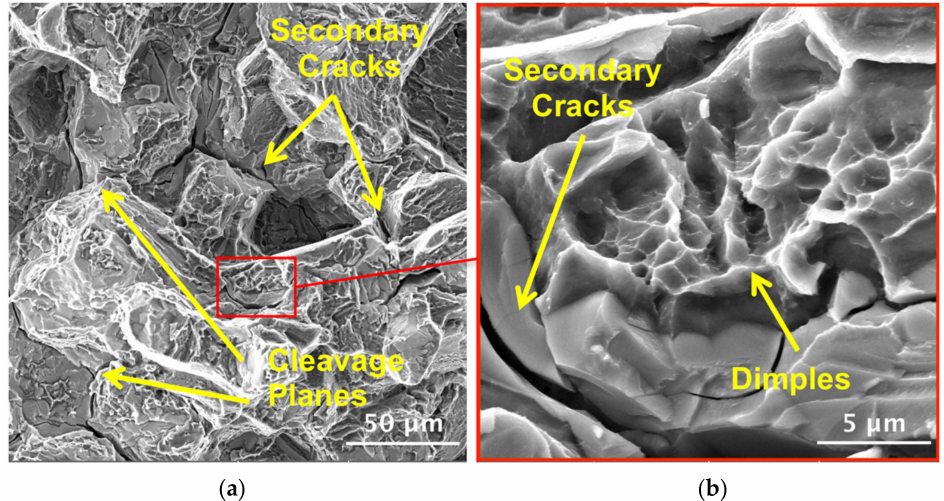
Figure 15. Fatigue tests (4-point rotating bending), fracture surface analysis: SEM images of the overloading region. Intergranular fracture with cleavage planes and secondary cracks ( a ) and small areas with ultrafine deep dimples ( b